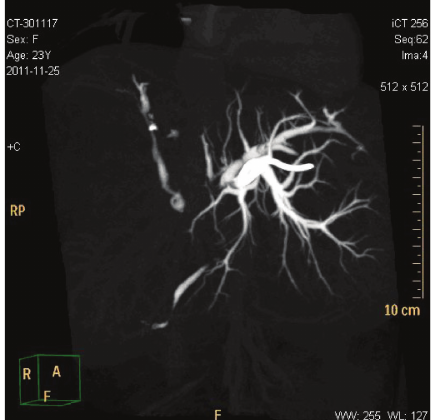
Figure 3: CT cholangiography showed filling defects in the right posterior sectoral duct, common hepatic duct, and